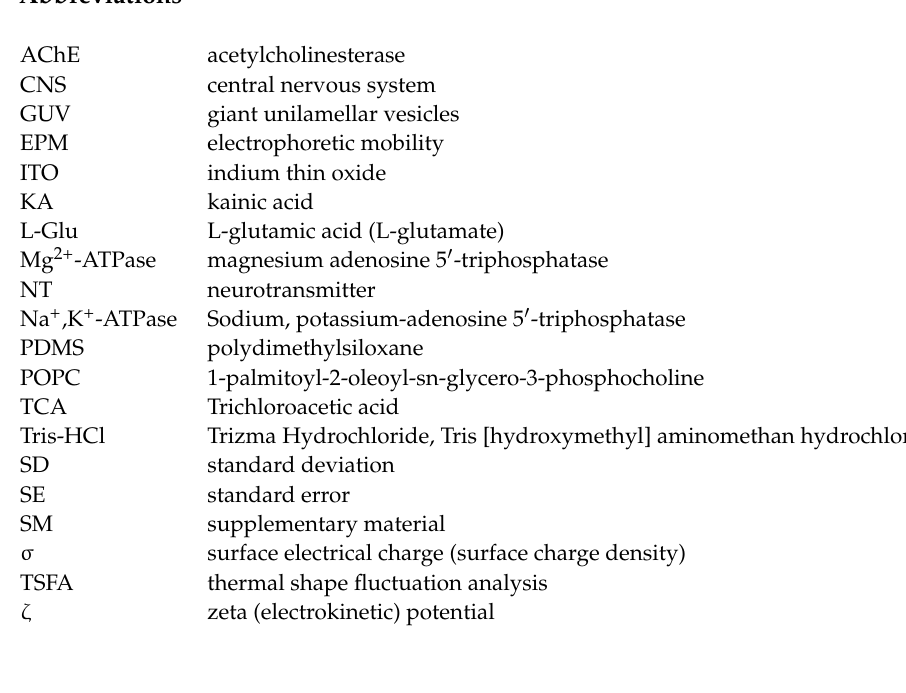
10 mM kainic acid, 50 mM Tris-HCl, pH 7.2 via electroformation at Upp = 4 V (peak-to-peak), 500 Hz for (a) 6 h; (b) 12 h. The scale bar corresponds to 10 µ m. Figure S4. Phase-contrast snapshots of vesicle preparations from POPC in 10 mM L-glutamic acid, 50 mM Tris-HCl, pH 7.2; electroformation at Upp = 4 V (peak-to-peak) and 10 Hz for (a) 12 h; (b) for 24 h. White arrows point at contact patches of adjacent vesicles adhered during elec-troformation. These aggregates remain stable after detachment of vesicles from lipid depots. The scale bar corresponds to 10 µ m. Figure S5. Phase- contrast snapshots of vesicle preparations from POPC in 1 mM L-glutamic acid, 50 mM Tris-HCl, pH 7.2 via electroformation at Upp = 4 V (peak-to-peak), 500 Hz for (a) 6 h; (b) 8 h. The scale bar corresponds to 10 µ m. Table S1. TSFA results for the radius Rves , membrane bending modulus k c , and tension σ of POPC GUVs; GF—goodness of fit ( χ 2